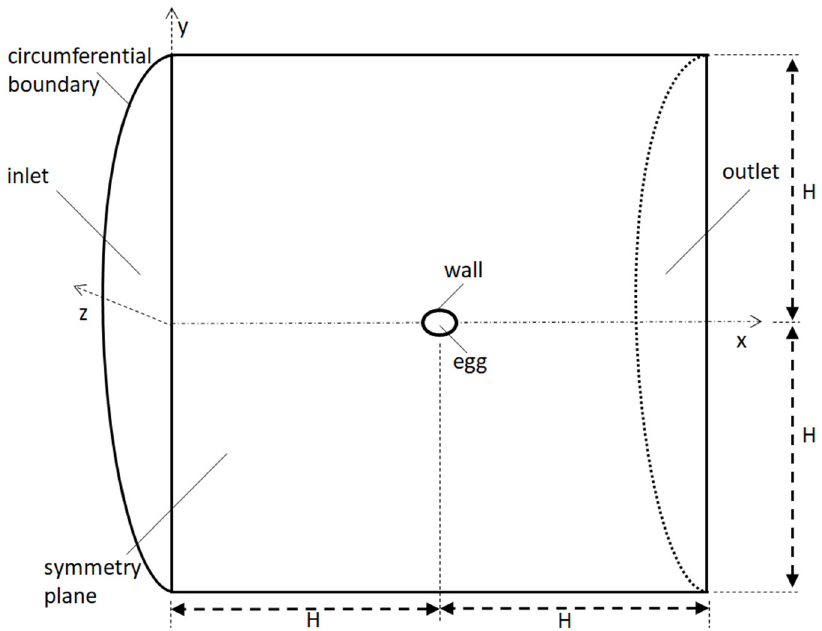
Figure 5. Sketch of solution domain.